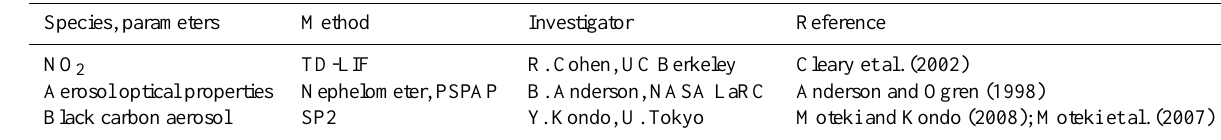
Table 1. DC-8 research payload during ARCTAS-B for the species considered in this study. Species,